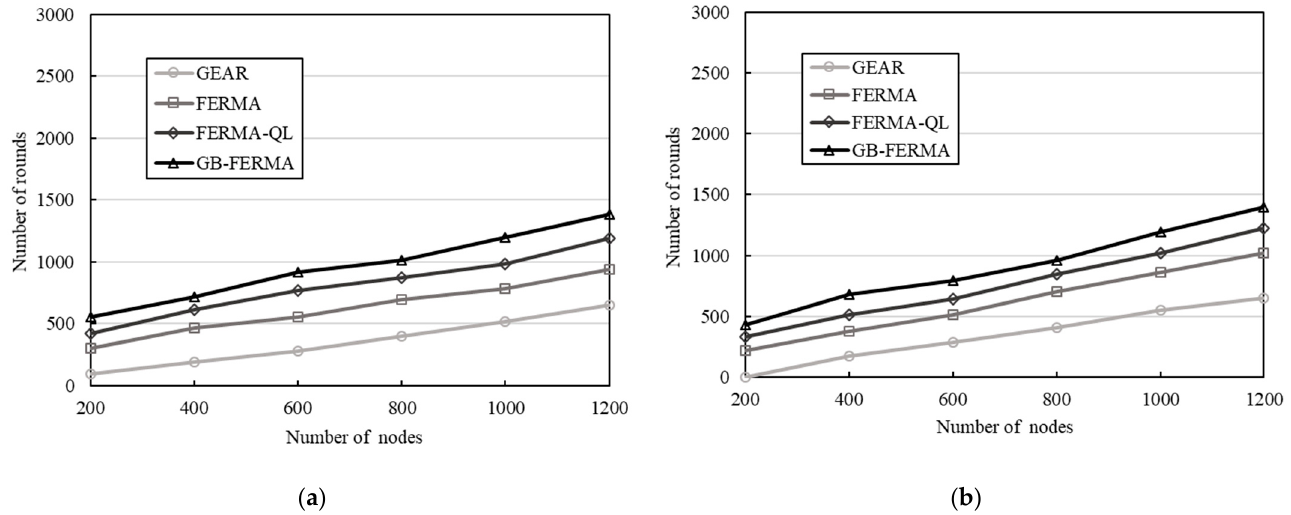
Figure 9. Number of rounds versus number of nodes: ( a ) initial power 0.25 J; ( b ) initial power 0.5 J.